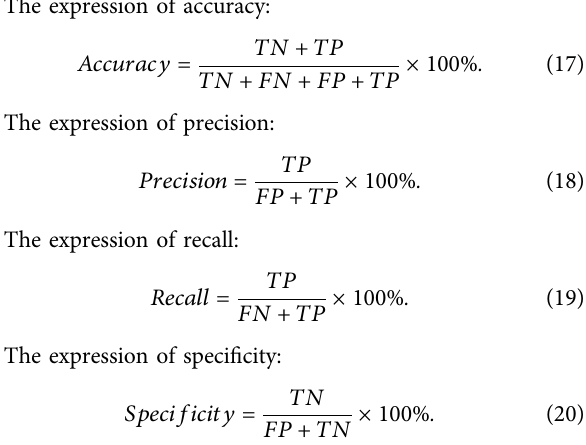
TABLE 1 | Confusion